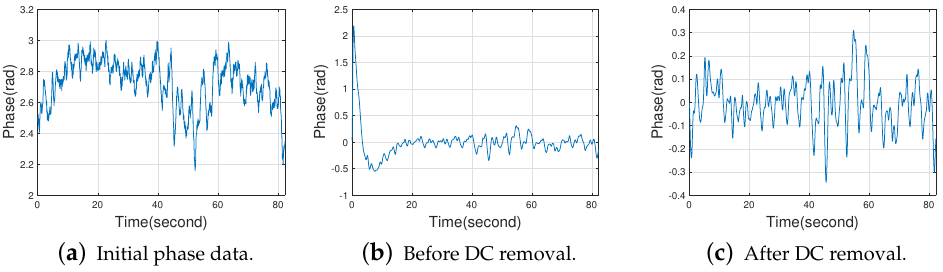
Figure 9. Effect of DC components on 2nd order Butterworth bandpass filtering. We found in our experiments that although the DC component has been removed, there is still a large amount of low-frequency noise around the DC component. This phenomenon can be seen in Figure 10b, and the initial phase data is also the result of Algorithms 1 and 2. Due to the large low-frequency noise near the DC component, we cannot get the desired result only by removing the DC component. If we want to extract the low-frequency respiratory information, it is necessary to use a band-pass filter to remove both low-frequency noise and high-frequency noise in the respiratory signal. We select the Butterworth bandpass filter as it has a magnitude response that is maximally flat in the passband and monotonic overall. This smoothness comes at the price of decreased rolloff steepness, while Elliptic and Chebyshev filters generally provide steeper rolloff for a given filter order. Since the human respiratory rate is about 0.2 Hz ∼ 0.27 Hz [30], the passband range is set to 0.1 Hz ∼ 1 Hz [15,36] in order to ensure that the spectrum in the respiratory rate range will not be lost. Figure 10 shows the initial phase data, the 1st to 4th order Butterworth bandpass filtering results of the initial phase data and their spectrums.